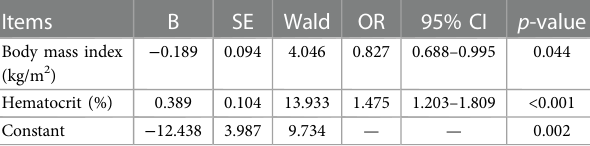
TABLE 3 Multivariate logistic regression of the construction of predictive